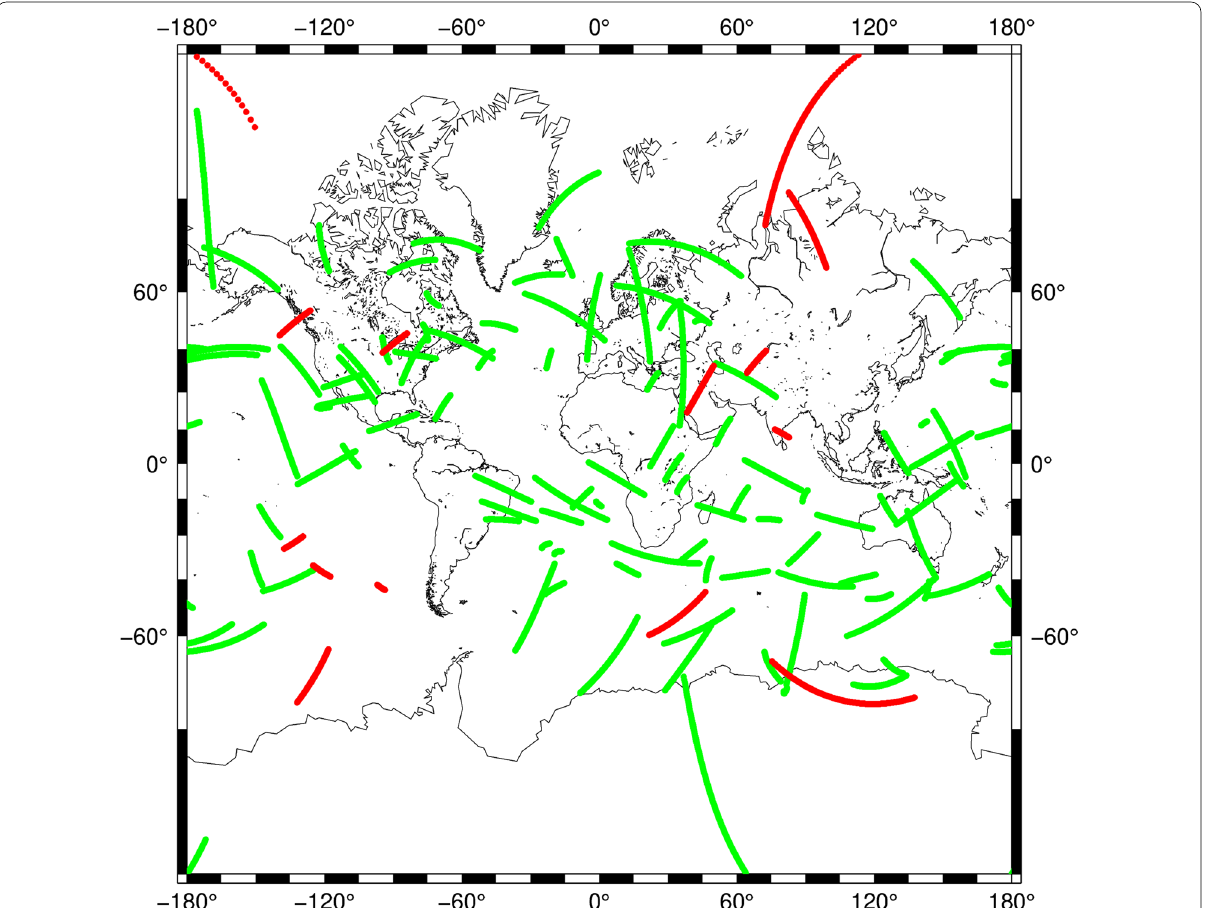
Fig. 4 F3C electron density profiles N e = N e ( x F3C ) (green) and GRACE electron density profiles N e = N e ( x GRACE ) (red) during the time interval 00:00 UT to 04:00 UT on March 12,